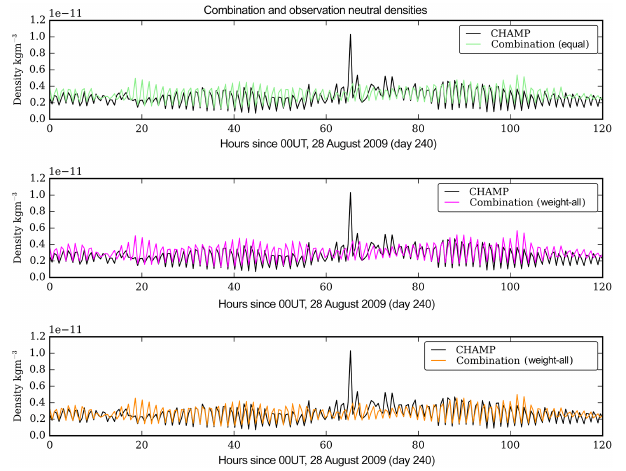
Figure 7. Modified Taylor diagram for the three MMEs: equal, quiet-time weighted, and all-time weighted as well as GITM, TIE- GCM, and NRLMSISE-00 (MSIS) compared to the CHAMP obser- vations for the first test scenario. Details of how to read the diagram are described in Fig.